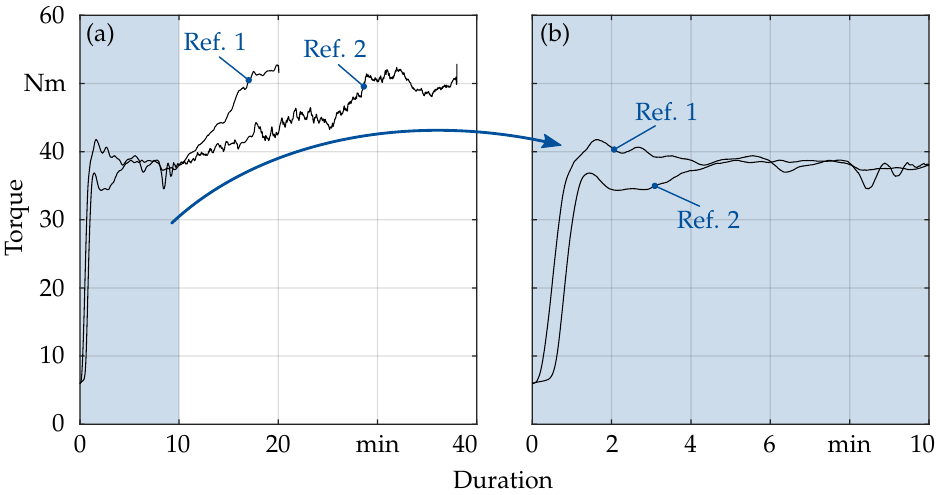
Figure 3. Overview of reference tests Ref. 1 and Ref. 2: ( a ) Frictional torque of the reference ex- periments to determine the operating life without lubricant displayed over the operating time. ( b ) Frictional torque curves observed in more detail from ( a ). Shown are the first 10 min with focus on the running-in